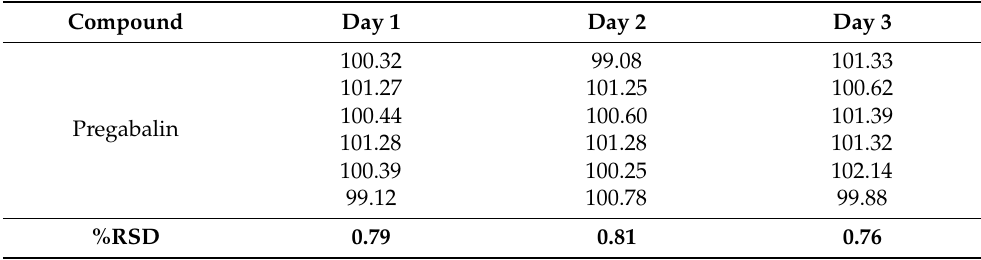
Table 3. Results of repeatability for 3 days ( n =